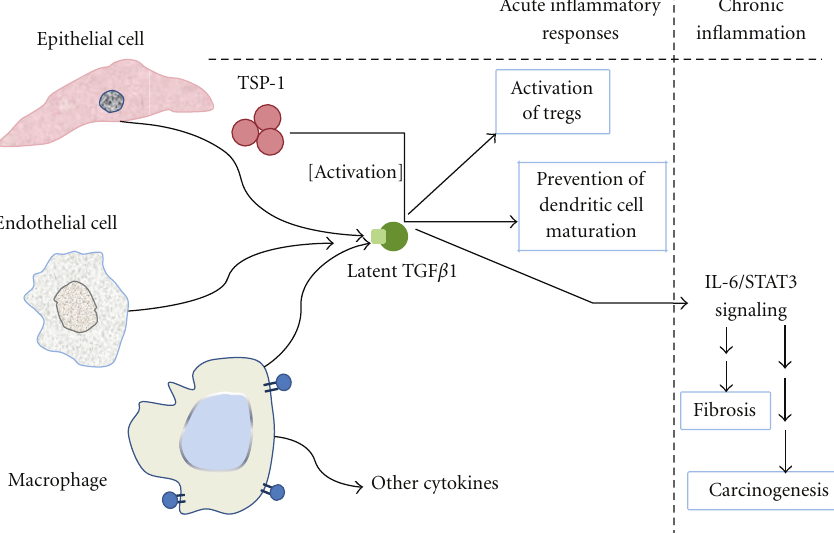
Figure 3: The homotrimeric TSP-1 activates latent TGF β 1 by binding the N-terminal propeptide LAP and the mature TGF β 1. The binding results in conformational changes in TGF β 1 and allows TGF β 1 to be recognized by its receptor. Mature, active TGF β 1 has been reported to decrease dendritic cell maturation and activate T cells. An opposing role of TGF β 1 results in